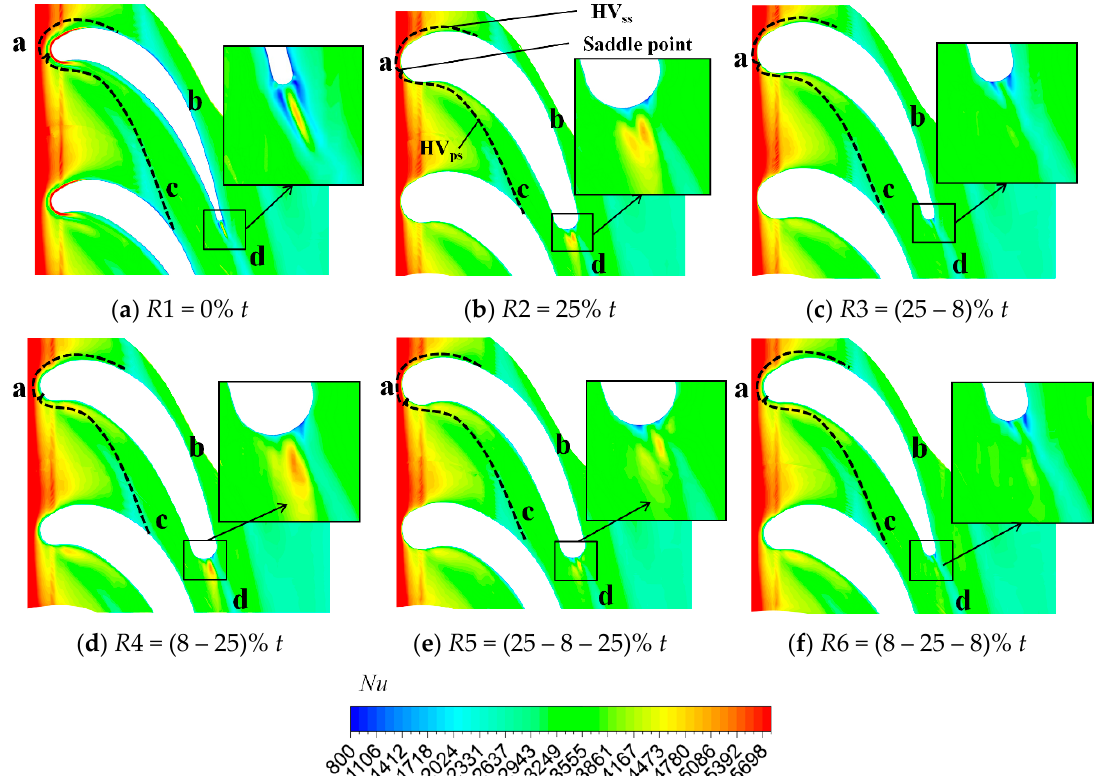
Figure 14. Distribution of Nu of shroud endwall of S2.